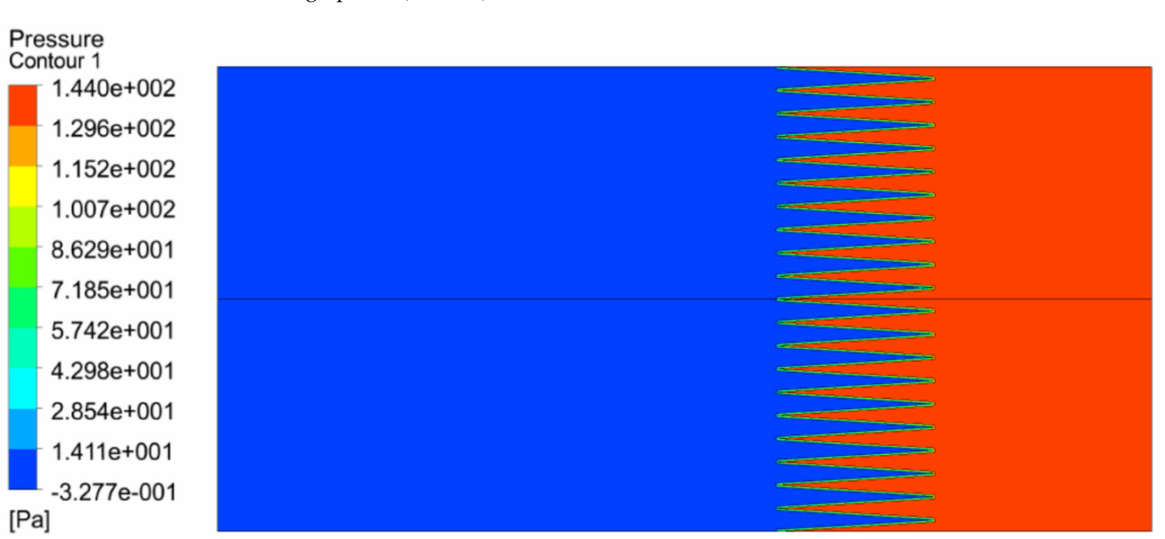
Figure 7. Velocity distribution in the symmetry plane ( top ) and detail of velocity streamlines passing through pleats ( bottom ).